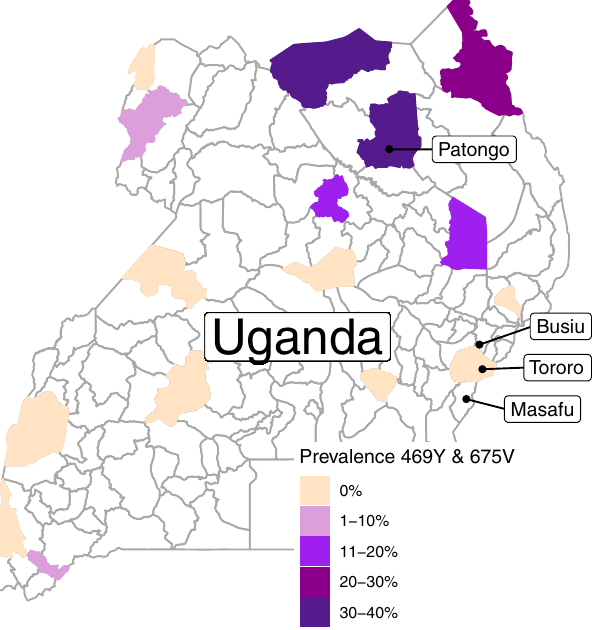
Fig. 1 | Map of Uganda. Study sites are labeled. The combined prevalence of the PfK13 469Y and 675V mutations in districts with available surveillance data